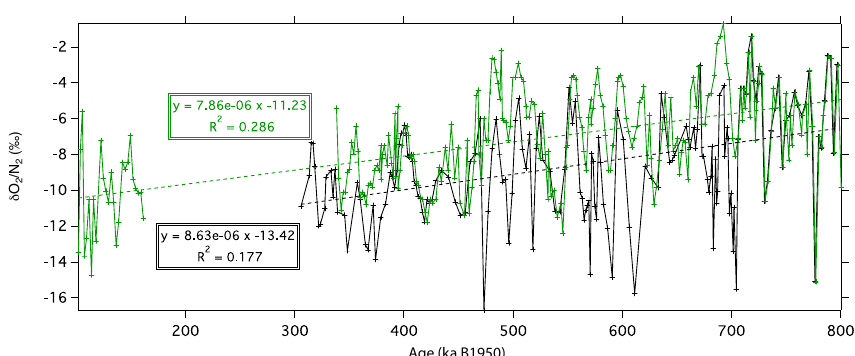
Figure A1. Comparison of the composite δ O 2 / N 2 record of Landais et al. (2012) (black) and the new δ O 2 / N 2 record measured on well- conserved ice (green). Both are presented on the AICC2012